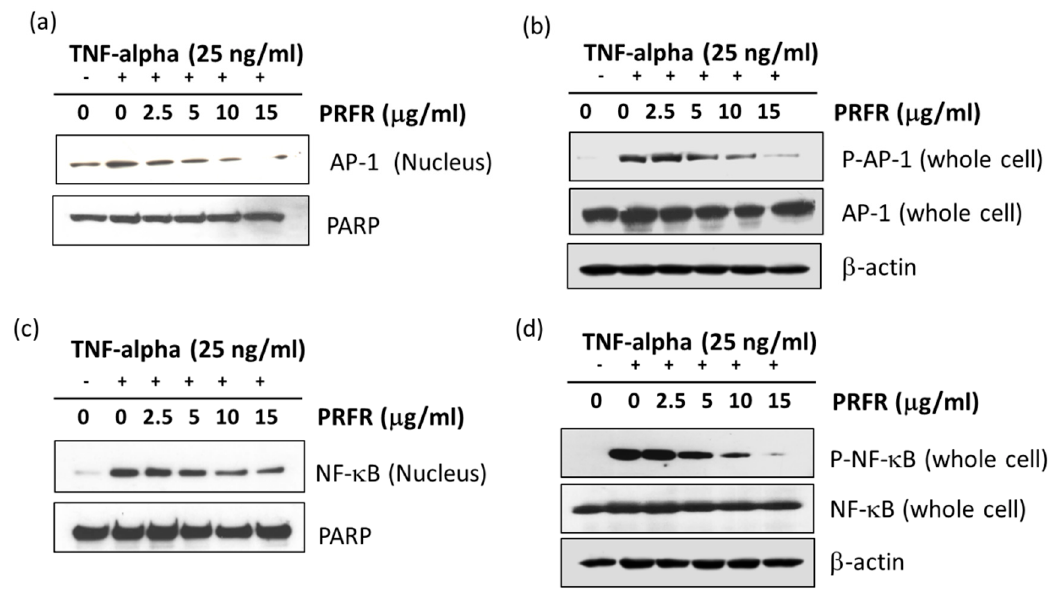
Figure 5. Effect of PRFR on TNF- α -induced NF- κ B and activator protein-1 (AP-1) activation. A549 cells were pretreated with PRFR and induced with TNF- α 25 ng/mL for 1 h. The nucleus-extracted fraction was prepared in order to detect c-Jun (AP-1) ( a ) and p65 (NF- κ B) levels ( c ) by western blot analysis. A549 cells were pretreated with PRFR for 12 h and induced with TNF- α 25 ng/mL for 15 min. The whole cell lysate was prepared for measurement of the phosphorylated and non- phosphorylated forms of AP-1 and NF- κ B ( b and d ). β -Actin and PARP were used as internal